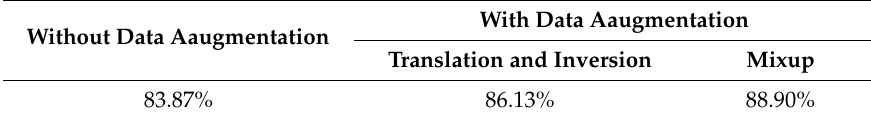
Table 3. E ff ectiveness of mix-up-based data augmentation (accuracy of ResNet50 with λ = 0.00).